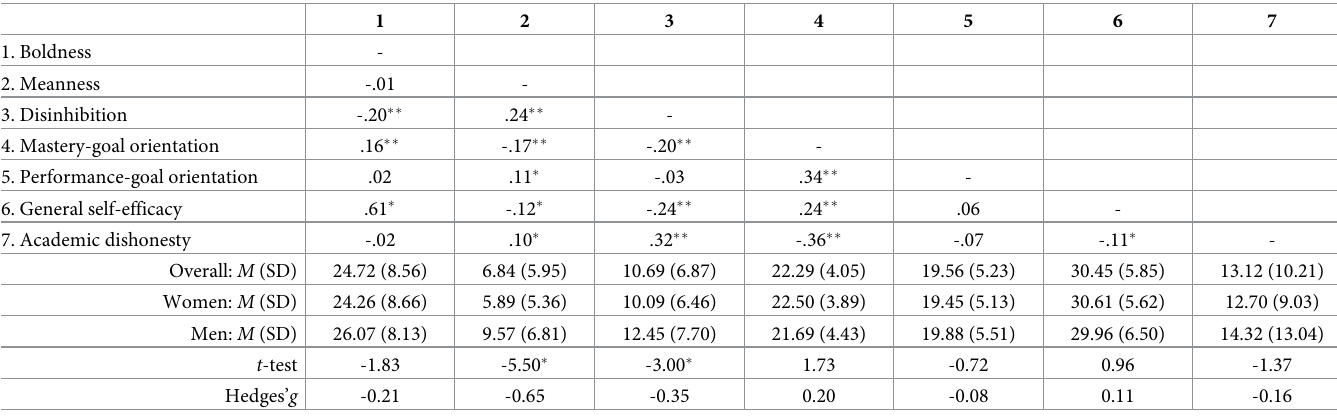
Table 1. Descriptive statistics, sex differences, and correlations for psychopathy facets, achievement goals, general self-efficacy, and academic